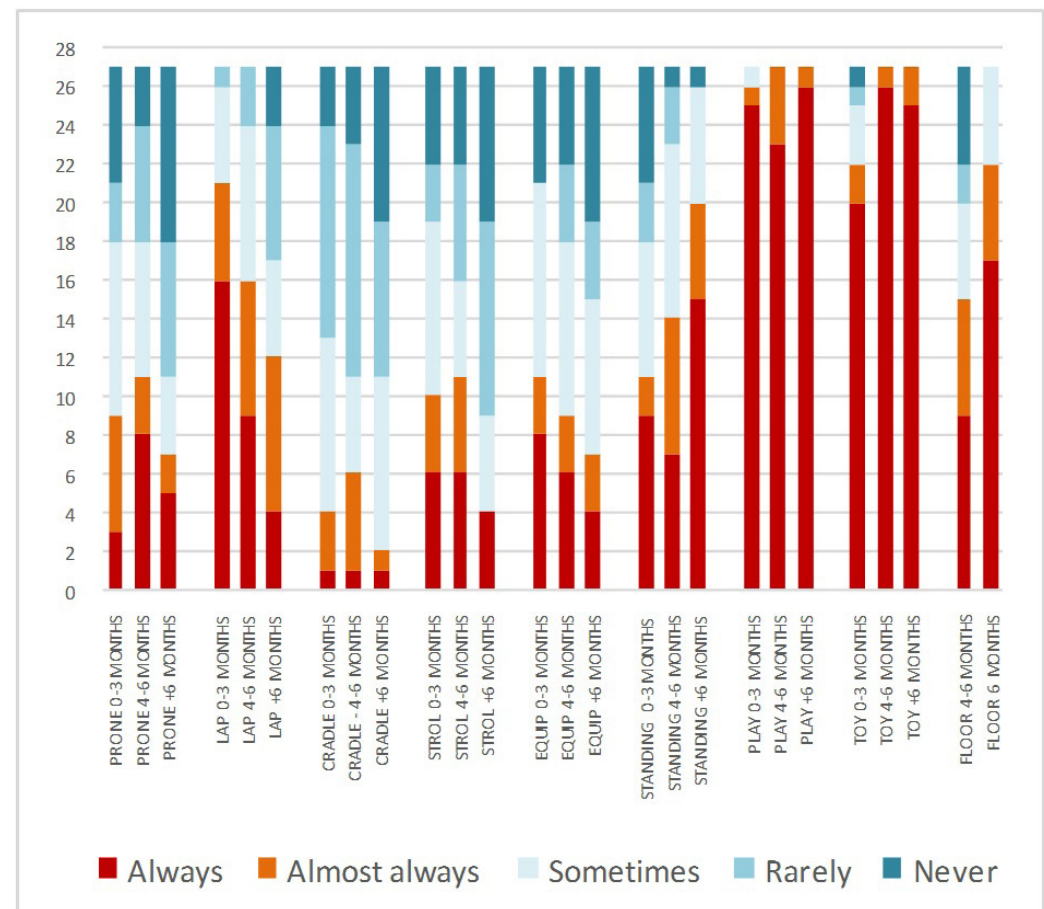
Figure 1 - Number of answers to the questionnaire – Parenting practices. Note: PRON: prone; STROL: Stroller; EQUIP: Equipment; TOY: